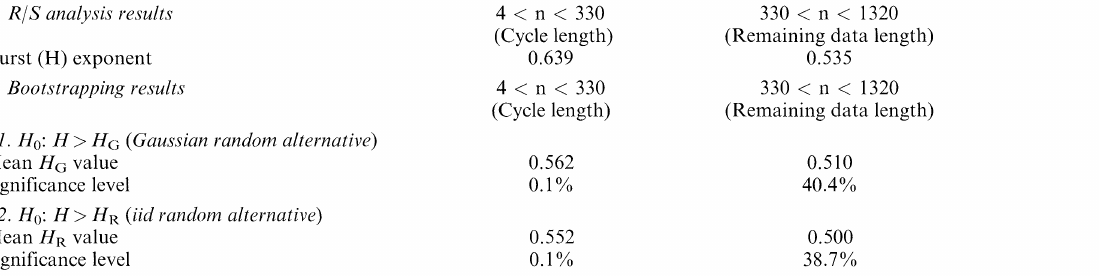
TABLE IX Hurst estimates and test of significance against two random alternatives of the daily DM/GRD returns A. R/S analysis results